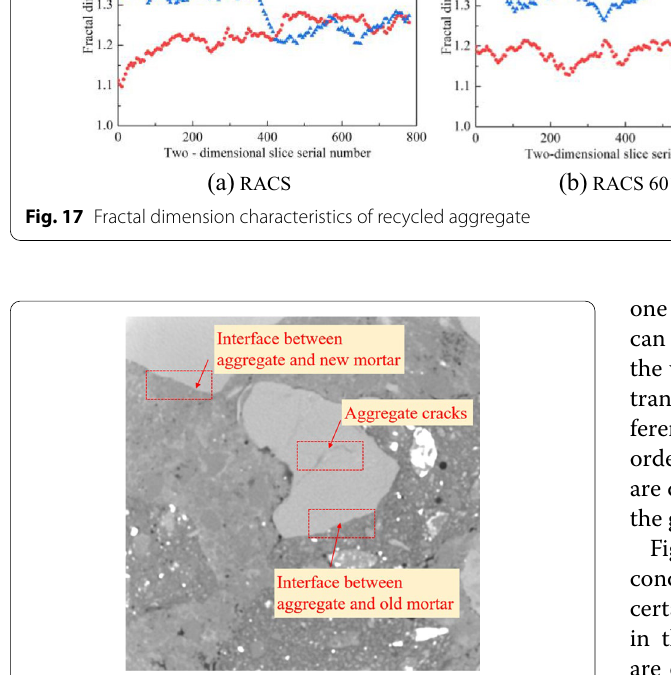
Fig. 18 Schematic diagram of the interface area and the micro-crack area inside the aggregate